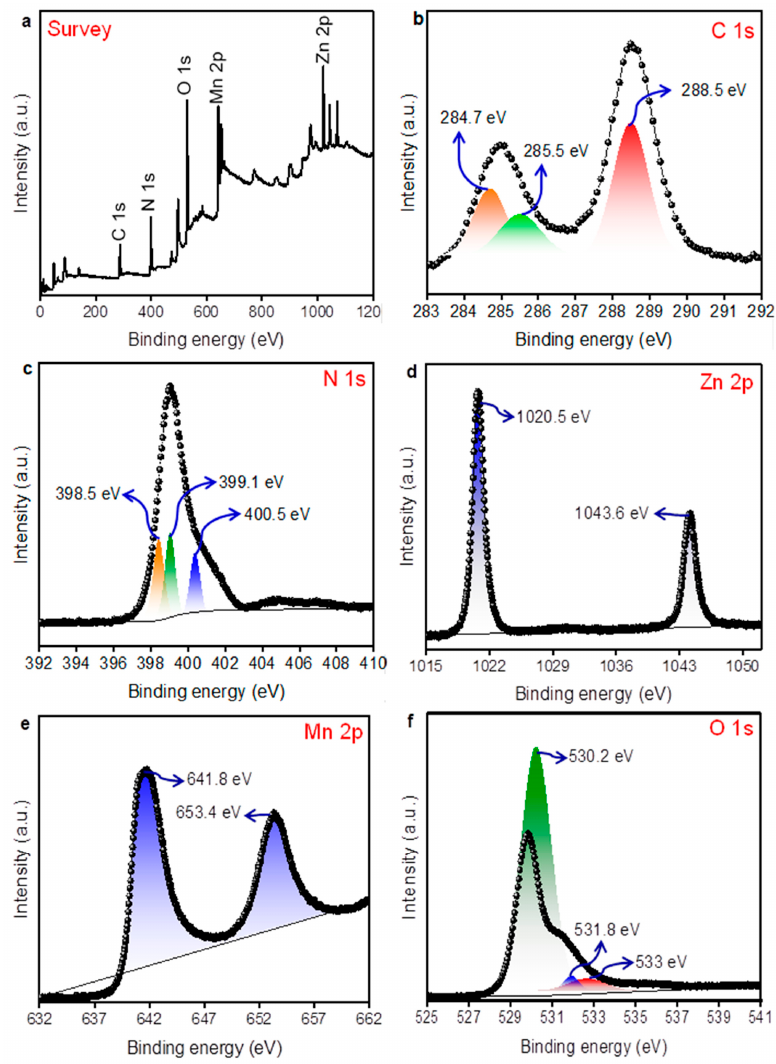
Figure 3. XPS spectra of CNDs/ZnMn 2 O 4 (20%) photocatalyst: ( a ) Survey, ( b ) C1s, ( c ) N1s, ( d ) Zn 2p, ( e ) Mn 2p, and ( f ) O1s spectra.